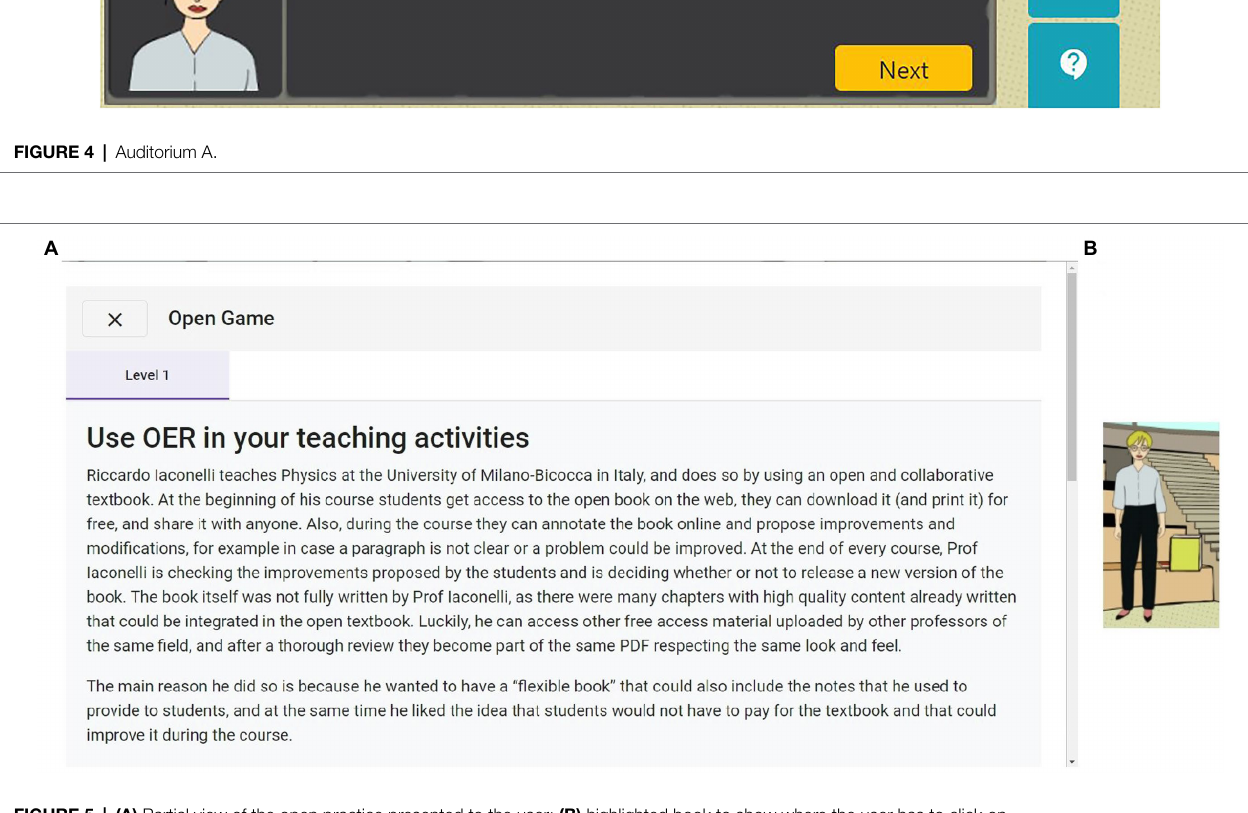
linked to that module is already achieved.